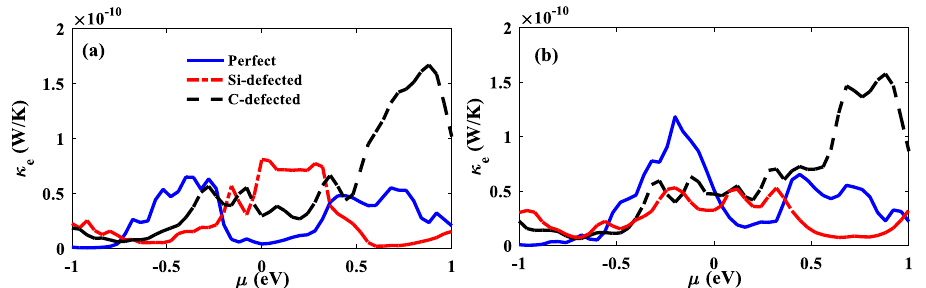
Figure 6. The electron thermal conductance of perfect (solid lines), Si-defected (dot-dashed lines), C-defected (dashed lines) of junctions as a function of chemical potential for P ( a ) and AP ( b ) electrodes configurations .